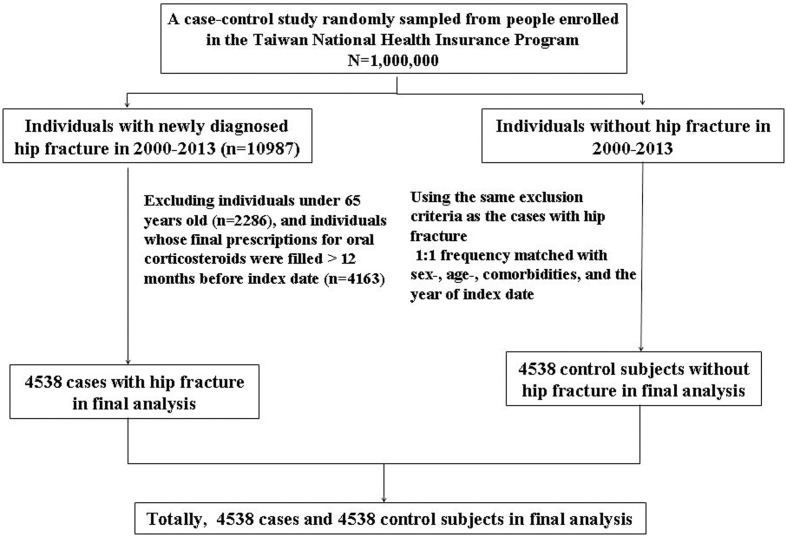
Flow chart shows selection process of cases with hip fracture and control subjects.